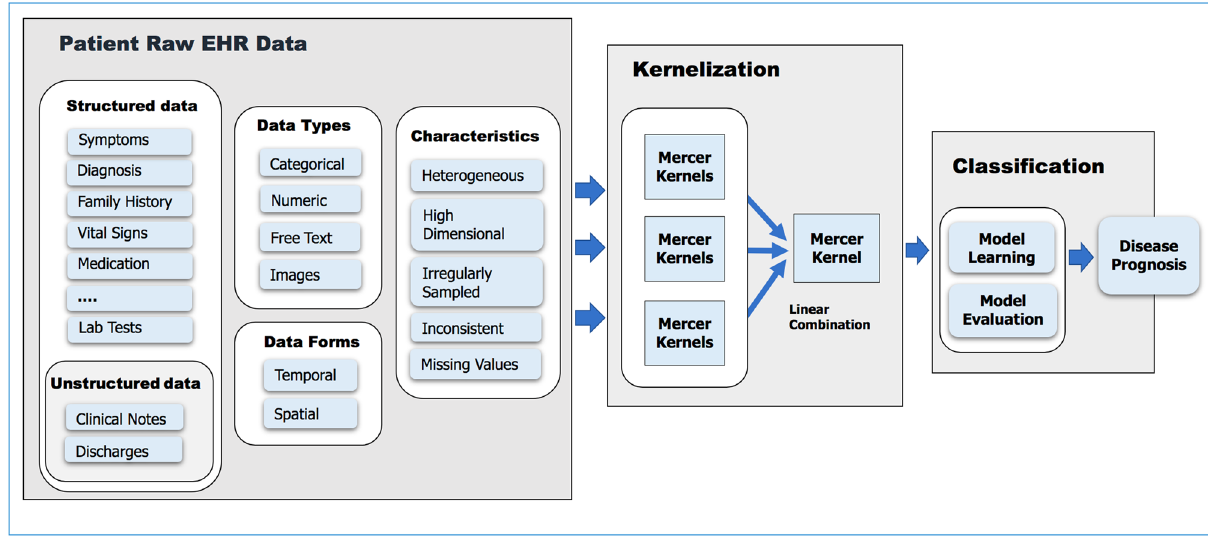
Figure 2. The proposed kernel framework for disease prognosis modeling with EHR